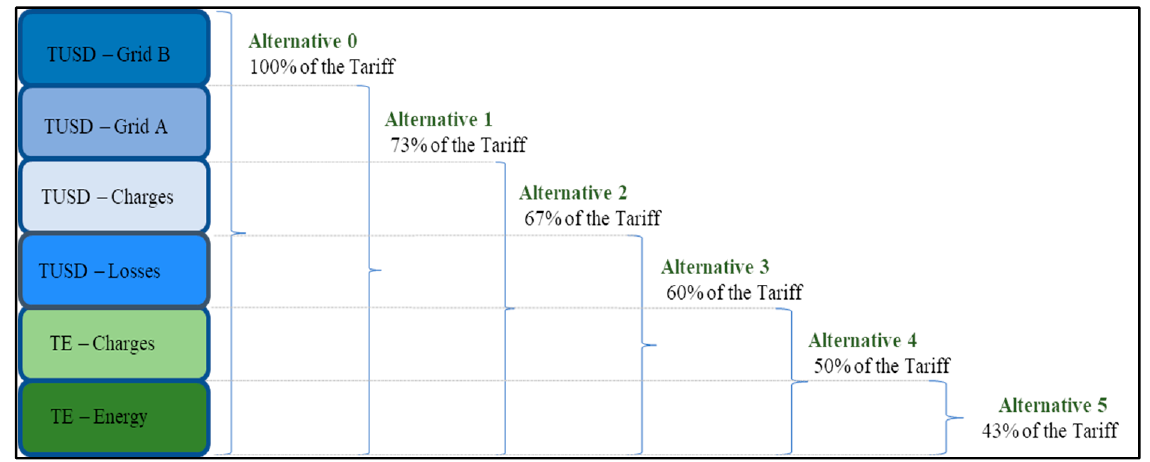
Figure 1. Tariff alternatives proposed by National Electric Energy Agency (ANEEL). Source: Adapted from CP 025/2019 [5] and Doyle et al. [18].